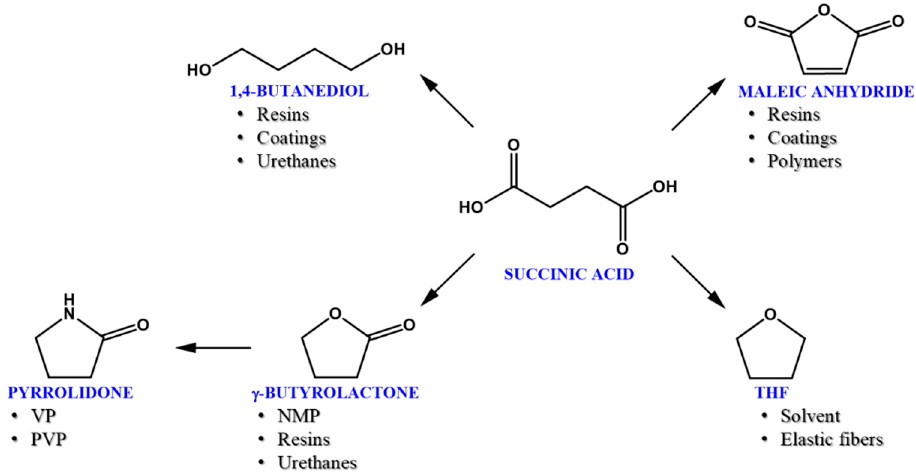
Figure 8. Possible routes by which renewable succinic acid can be further converted into value added products under heterogeneous